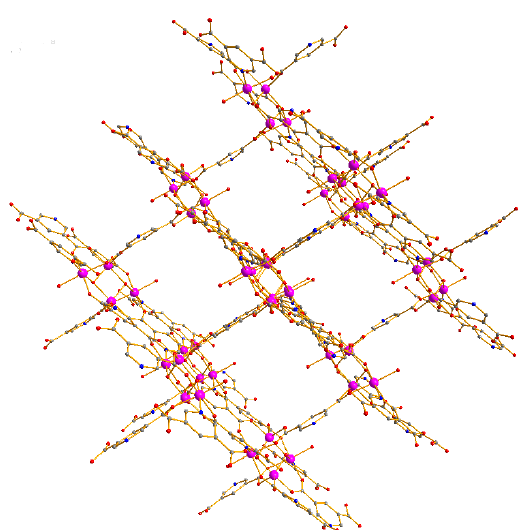
Figure 2. The 3D structure of the compound.